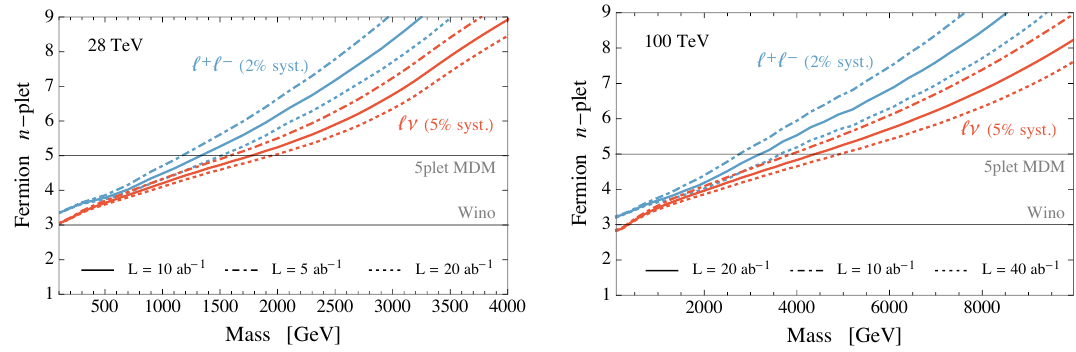
Figure 10 . Dependence of the 95% CL exclusion bounds on the integrated luminosity at the HE-LHC (left panel) and at the FCC-100 (right panel). The red and blue lines correspond to the bounds from the ‘(cid:23) and ‘ + ‘ (cid:0) (cid:12)nal states.